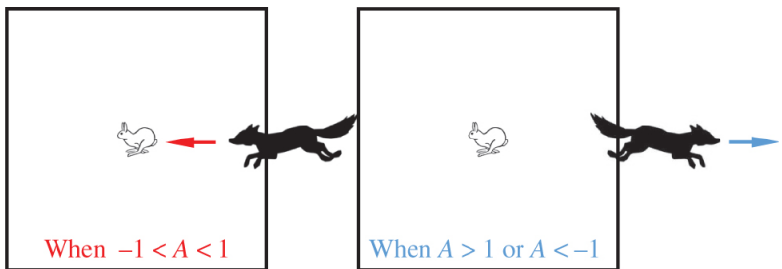
Figure 3. Exploration and Exploitation in GWO.